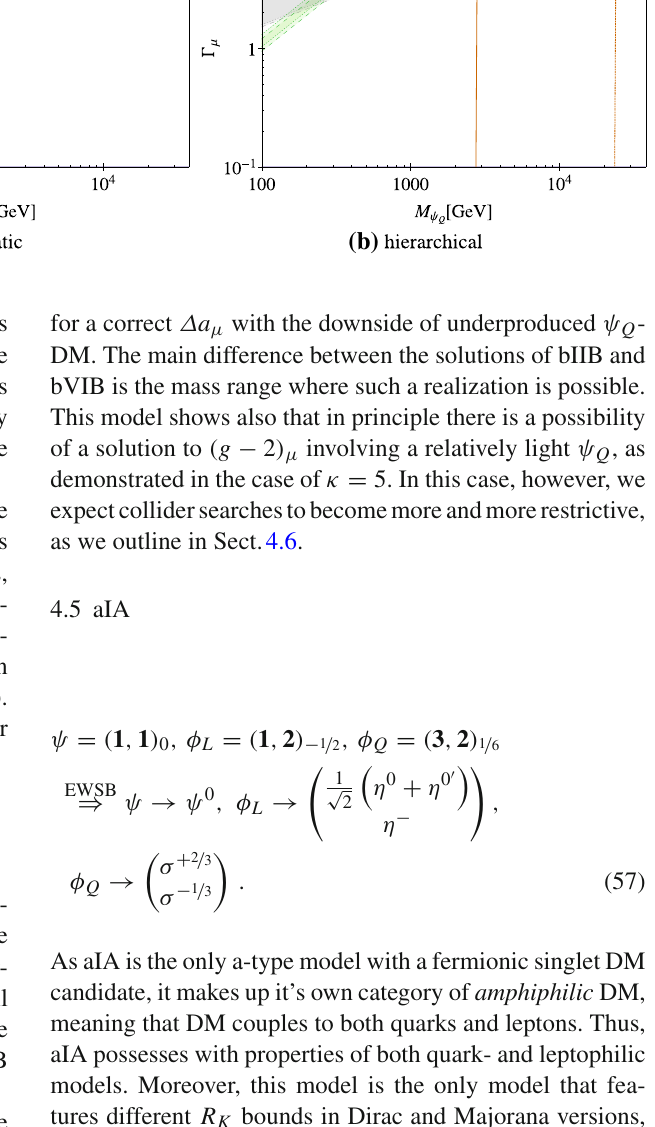
Fig. 12 Summary plot for Dirac DM in bVIB. The legend and an explanation of the color scheme are given in